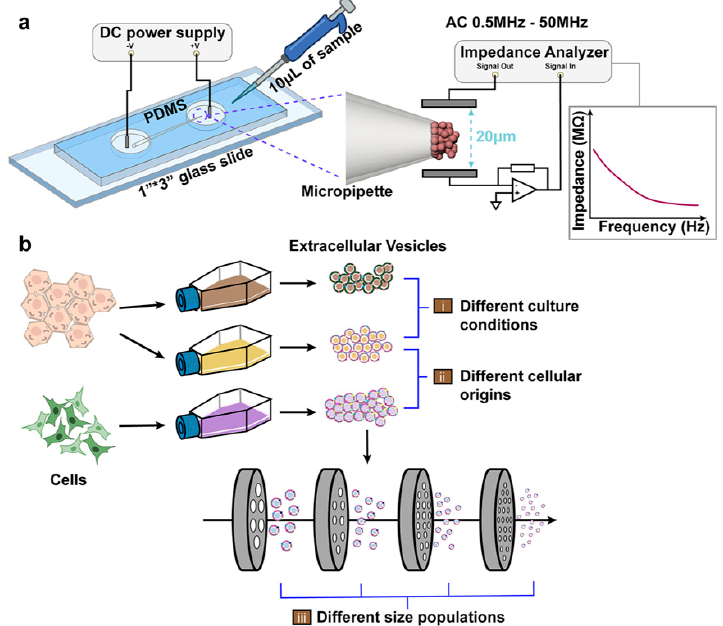
Figure 1. ( a ) Schematic of an integrated iDEP and EIS system. The setup was composed of a borosilicate micropipette placed in between two PDMS chambers. DC bias was applied to trap vesicles at the pipette’s tip by electrokinetic forces, followed by measuring of the impedance of the collected vesicles, utilizing the sensing electrodes, at a wide frequency spectrum (0.5 MHz to 50 MHz). ( b ) Detection of EVs harvested from: ( i ) cells under different culture conditions, ( ii ) different cellular origins, and (iii) populations of different sizes.